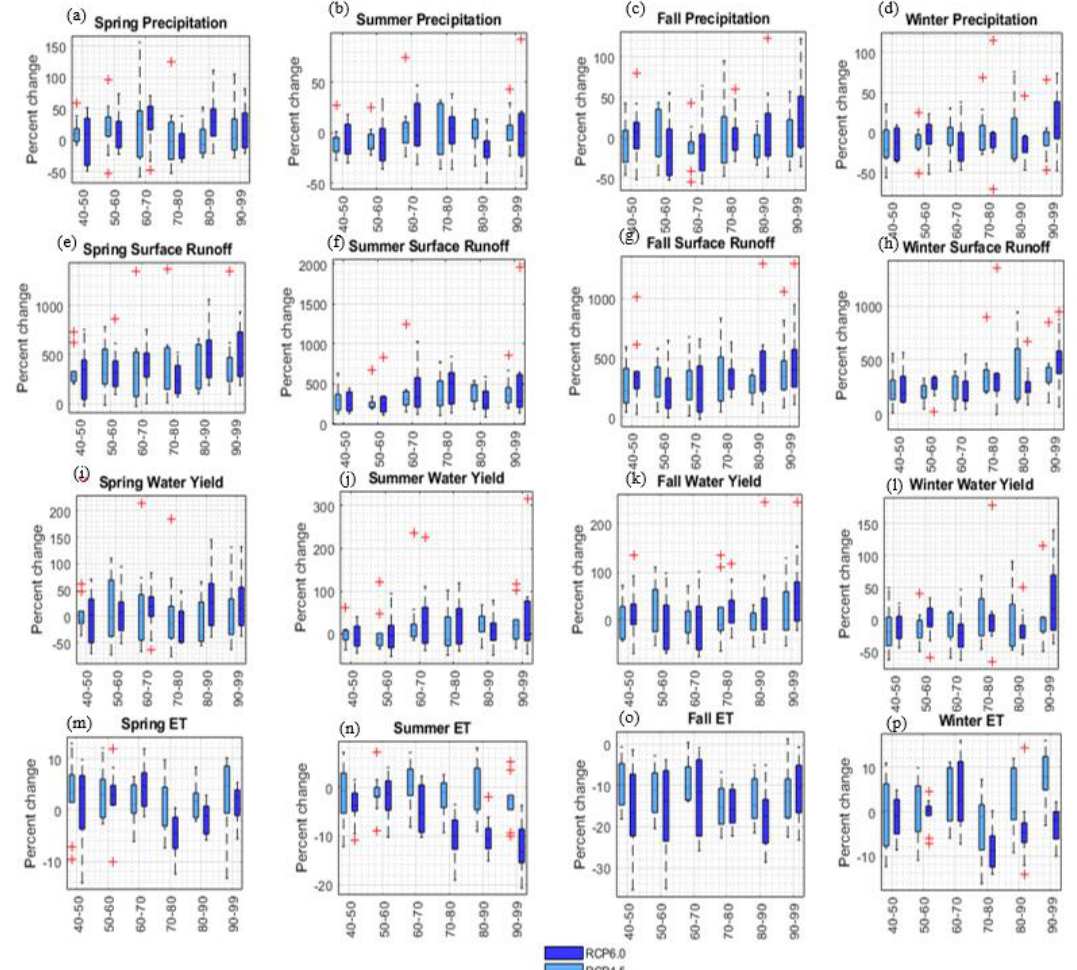
Figure 11. Seasonal variation of hydrological components based on the model and under both emissions scenarios for the entire simulation period. The top panel shows projected seasonal variation of rainfall compared to the baseline for each future decade during each season ( a , b , c , d ). The second panel from the top, presents projected seasonal variation of surface runoff compared to the baseline for each future decade during each season ( e , f , g , h ). The third panel from the top, presents projected seasonal variation of water yield compared to the baseline for each future decade during each season ( i , j , k , l ). The bottom panel illustrates projected seasonal variation of ET compared to the baseline for each decade during each season ( m , n , o , p ).